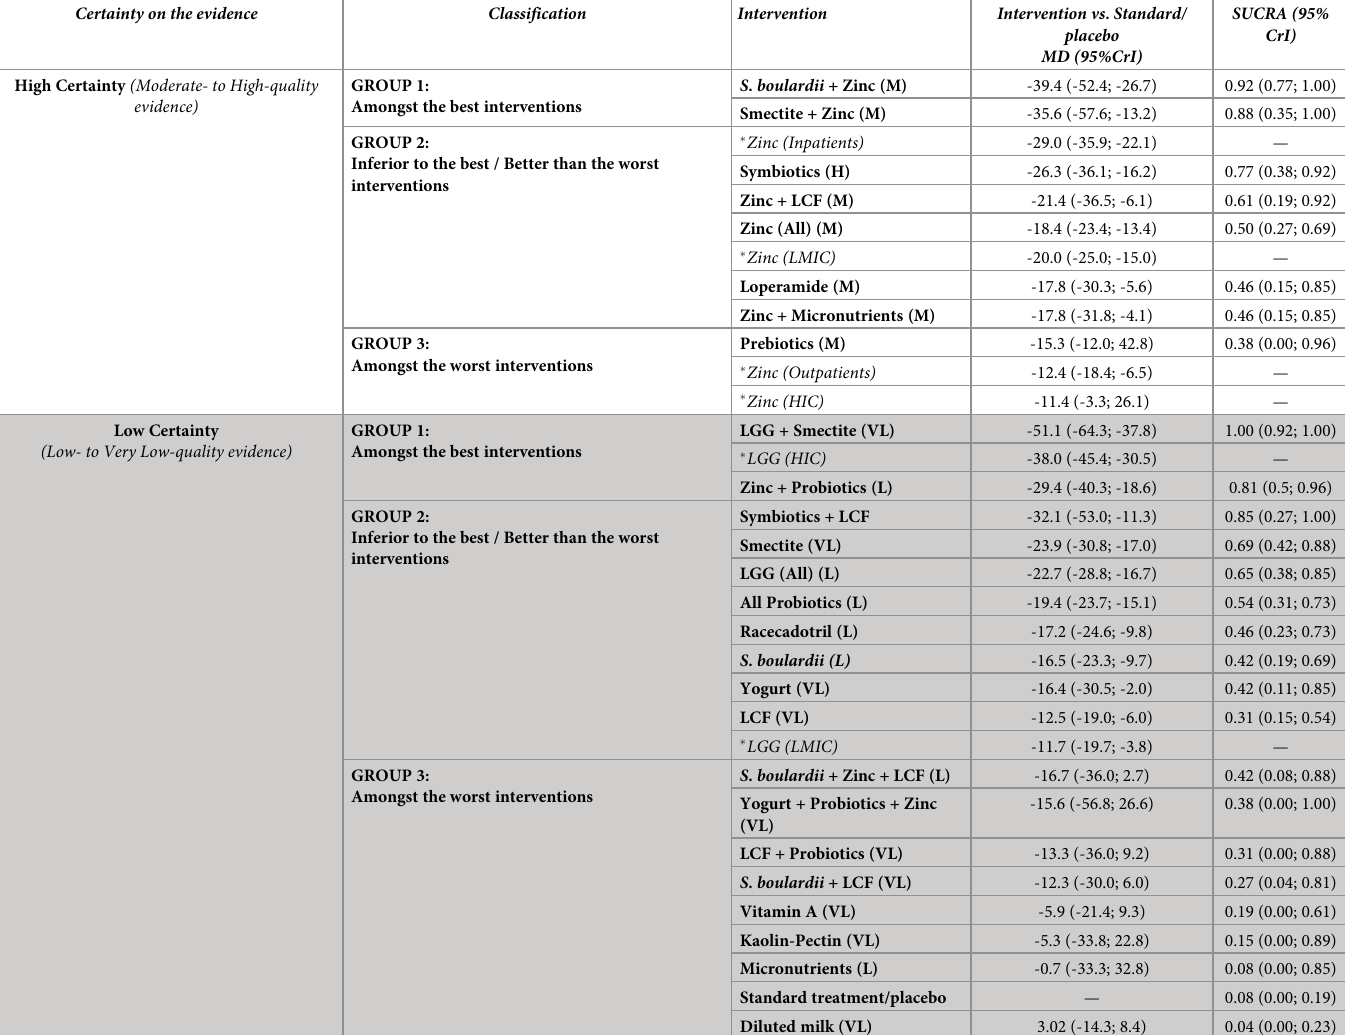
Table 2. Summary of results for diarrhea duration in hours. Certainty on the evidence